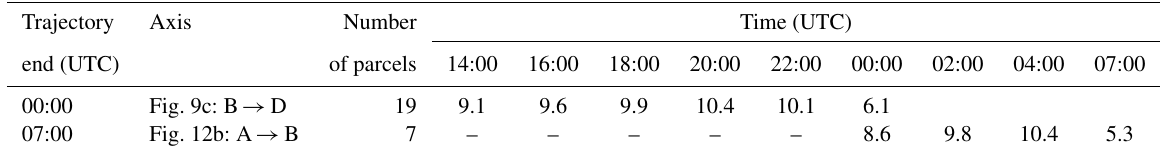
Figure 9. (a) Horizontal projection of the 40 backward trajectories from air parcels taken inside the atmospheric column located in “D” (43.25 ◦ N, 2.25 ◦ E) at 00:00UTC on 15 October in the REF simulation. Trajectories in colour are the ones projected in (b–d) : their colour varies according to the water vapour mixing ratio of the parcels. Other trajectories are in grey. Trajectories are computed until 12:00UTC on 14 October, except for parcels that reach domain boundaries before that time. (b–d) Vertical projections of backward trajectories along the dashed black lines shown in (a) and corresponding cross-sections of virtual potential temperature at 00:00UTC on 15 October. Each parcel is projected on the section closest to its trajectory inland. Terrain is in black. Table 1. Mean water vapour mixing ratio (gkg − 1 ) of air parcels originating from below 1500m height along axes shown in Figs. 9 and 12 as a function of time. Dashes indicate that at least one parcel was out of the simulated domain at that